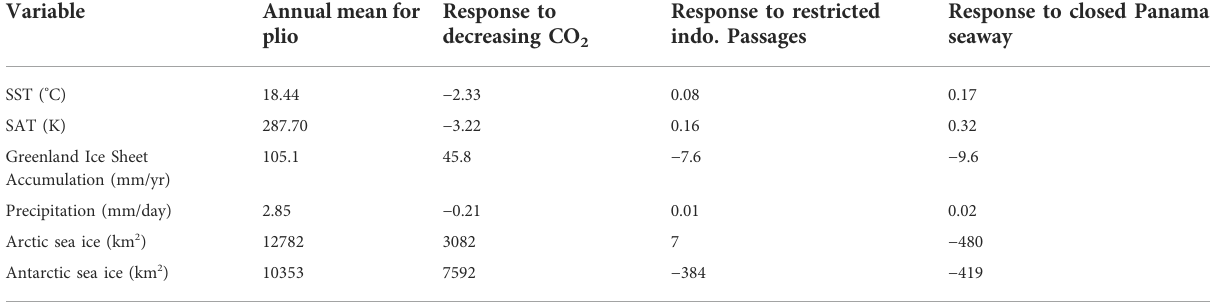
TABLE 2 Global mean statistics for all experiments. Response to decreasing CO 2 is de fi ned as the difference between the Pre-industrial and Plio. Response to the restricted Indo. Passages is de fi ned as the difference between the Plio and Indo. Passages. Response to the closed Panama Seaway is de fi ned as the difference between the Plio and Panama